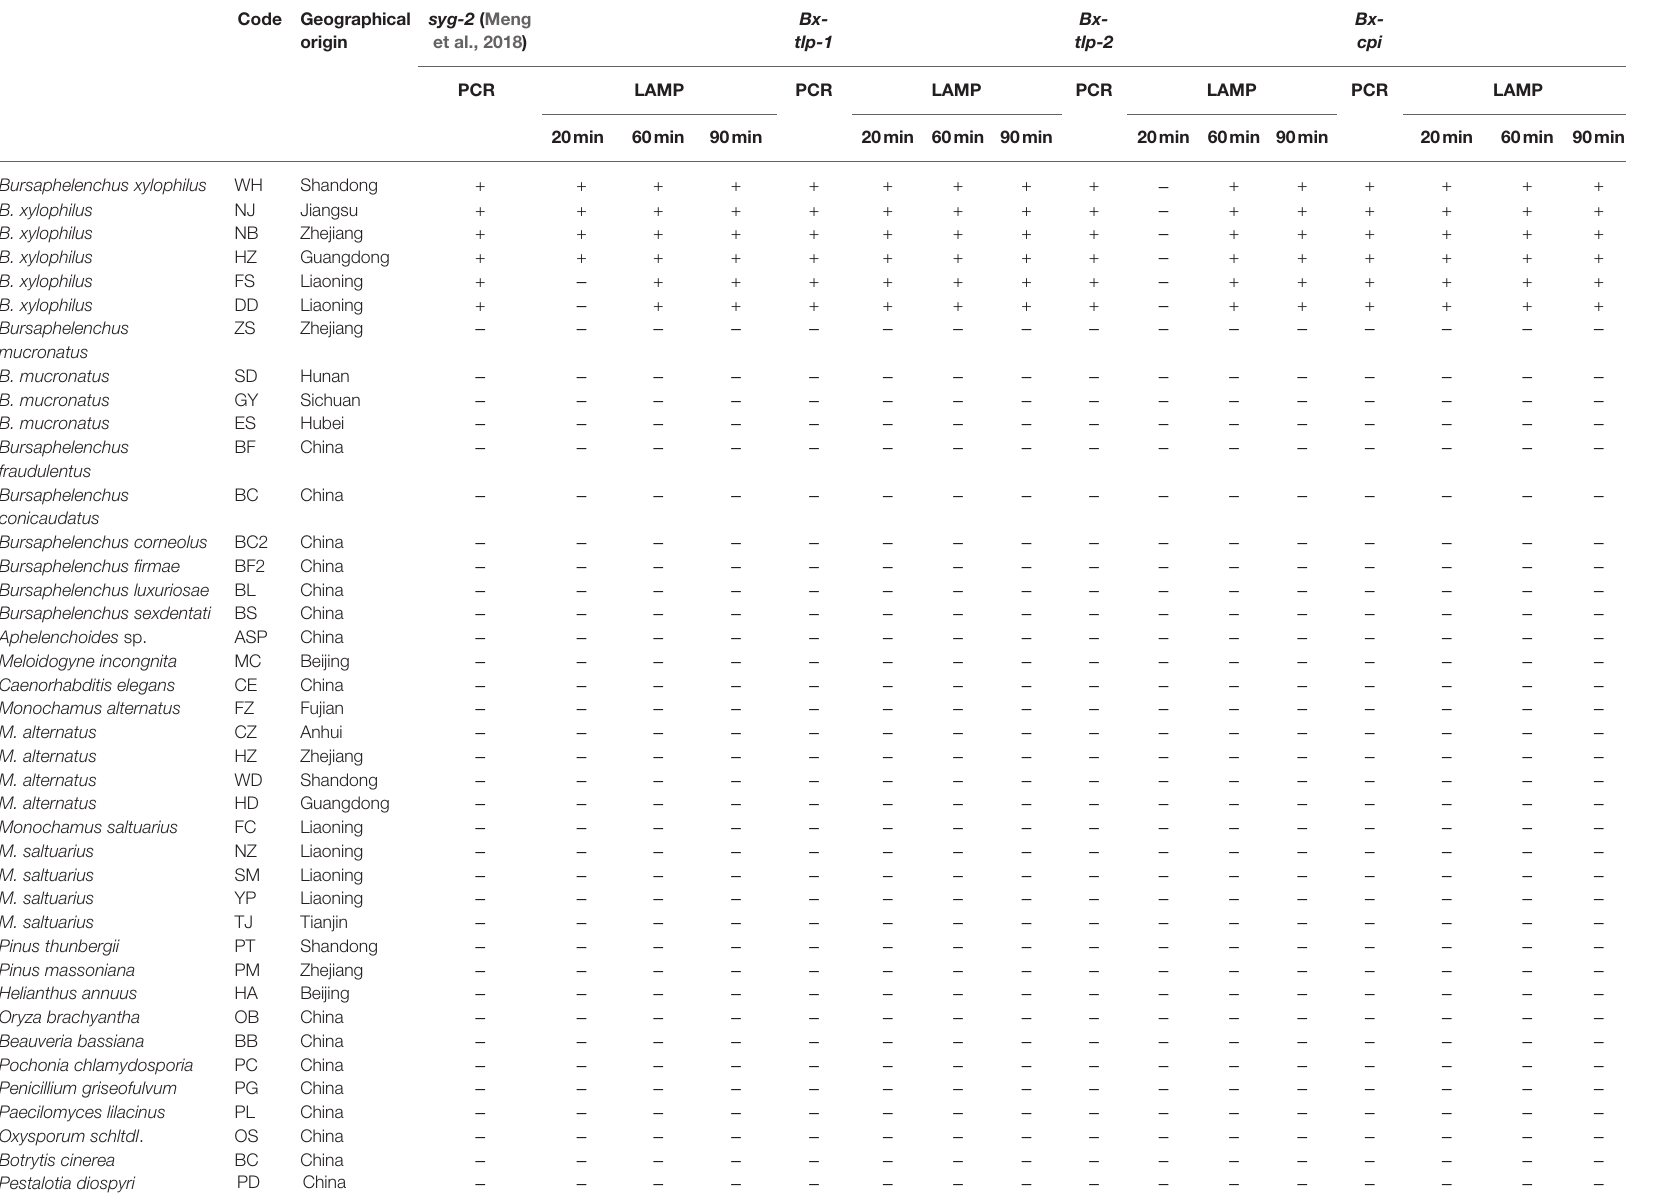
TABLE 2 | Specificity of the PCR and Loop-Mediated Isothermal Amplification (LAMP) assays for Bursaphelenchus xylophilus